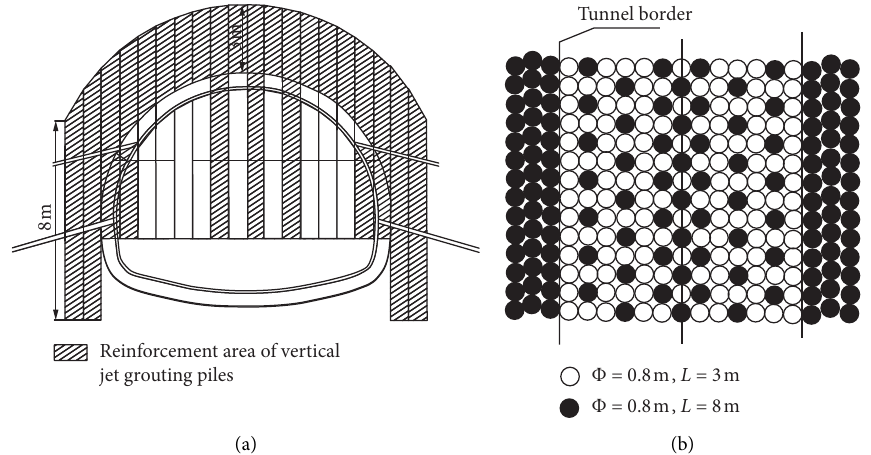
Figure 5: Arrangement of vertical jet grouting piles. (a) Vertical section, (b) horizontal section [39–41].